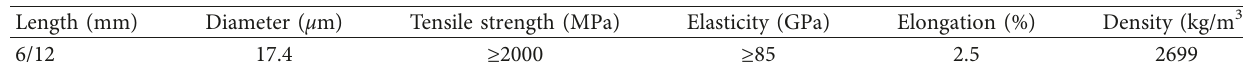
Table 7: Properties of basalt